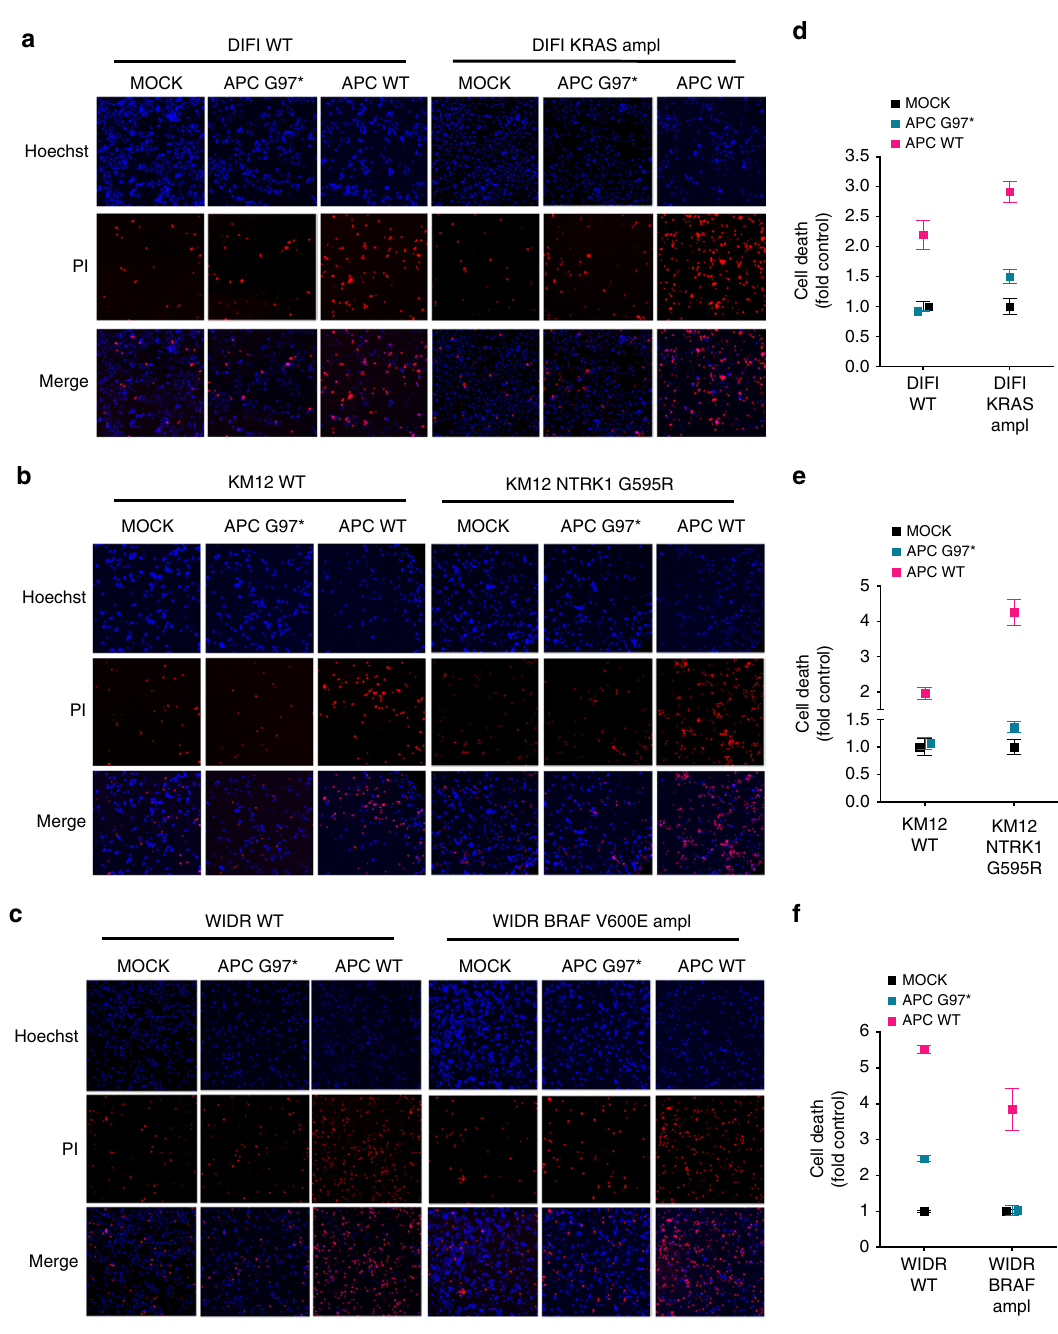
Fig. 3 Functional restoration of WTAPC induces cell death in CRC cells carrying distinct mechanisms of secondary resistance. a – c Parental and resistant- derivatives CRC cells were electroporated with plasmid encoding for WTAPC or an inactive APC version (G97*). Electroporation buffer alone was used as control (mock). After 48 h, cells were stained with Hoechst 3342 /Propidium Iodide (PI) to detect cell death. Representative images of single 96-wells are shown for each condition. d – f Relative quanti fi cation of Hoechst/PI positive cells was made using ImageJ software and normalised against mock cells. Results represent means ± SD of three independent